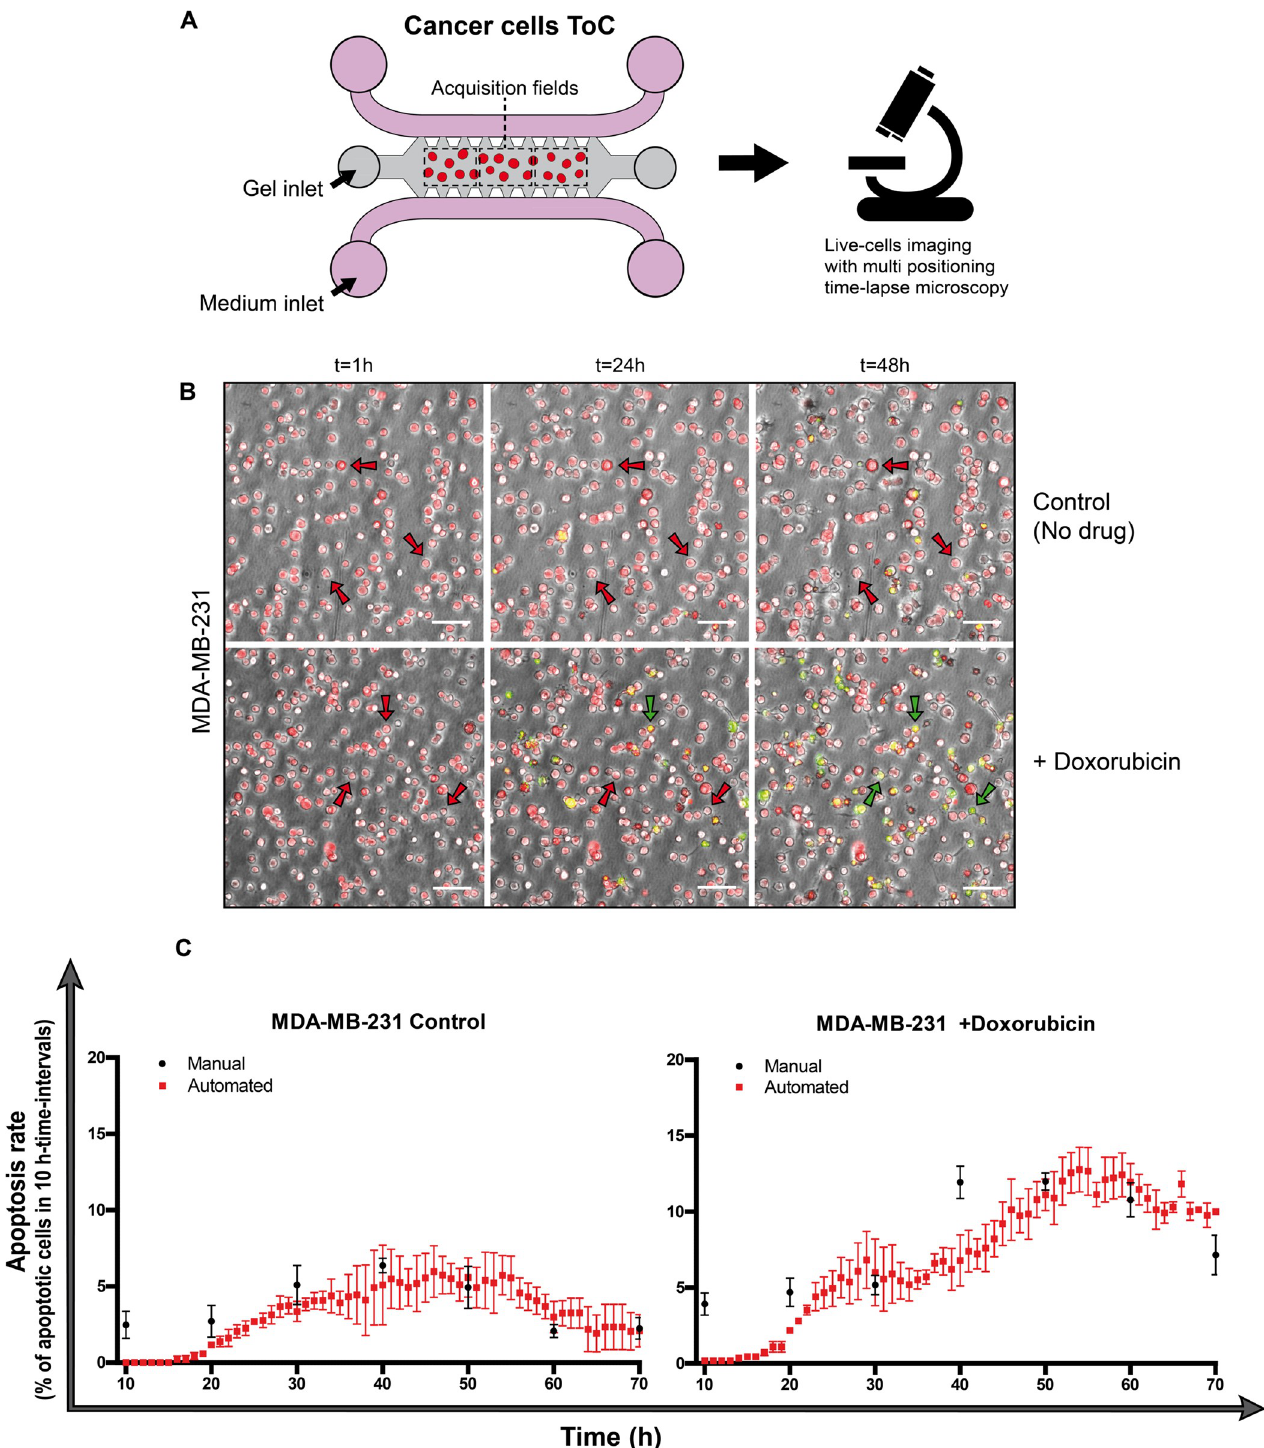
Fig 2. Chemotherapy-mediated cytotoxicity in breast-cancer-on-chip cultures. A. Experimental design: breast cancer MDA-MB-231 cells are embedded in a collagen matrix in the central chamber of the chip; cells are live-imaged in transmission channel and fluorescence channels (red and green) every hour for 72 h, without or with doxorubicin (1 μ M). B. Representative images of MDA-MB-231 cells after 1 h, 24 h and 48 h of culture on-chip, without drug (uppers panels) or with doxorubicin (lowers panels). Red arrows indicate living cells, whereas green arrows point at apoptotic cells. Scale bar, 100 μ m. C. Time-course quantifications of the apoptosis rate, calculated in 10 h-time-intervals, showing the comparison between manual counts (black rounds) and automatic counts